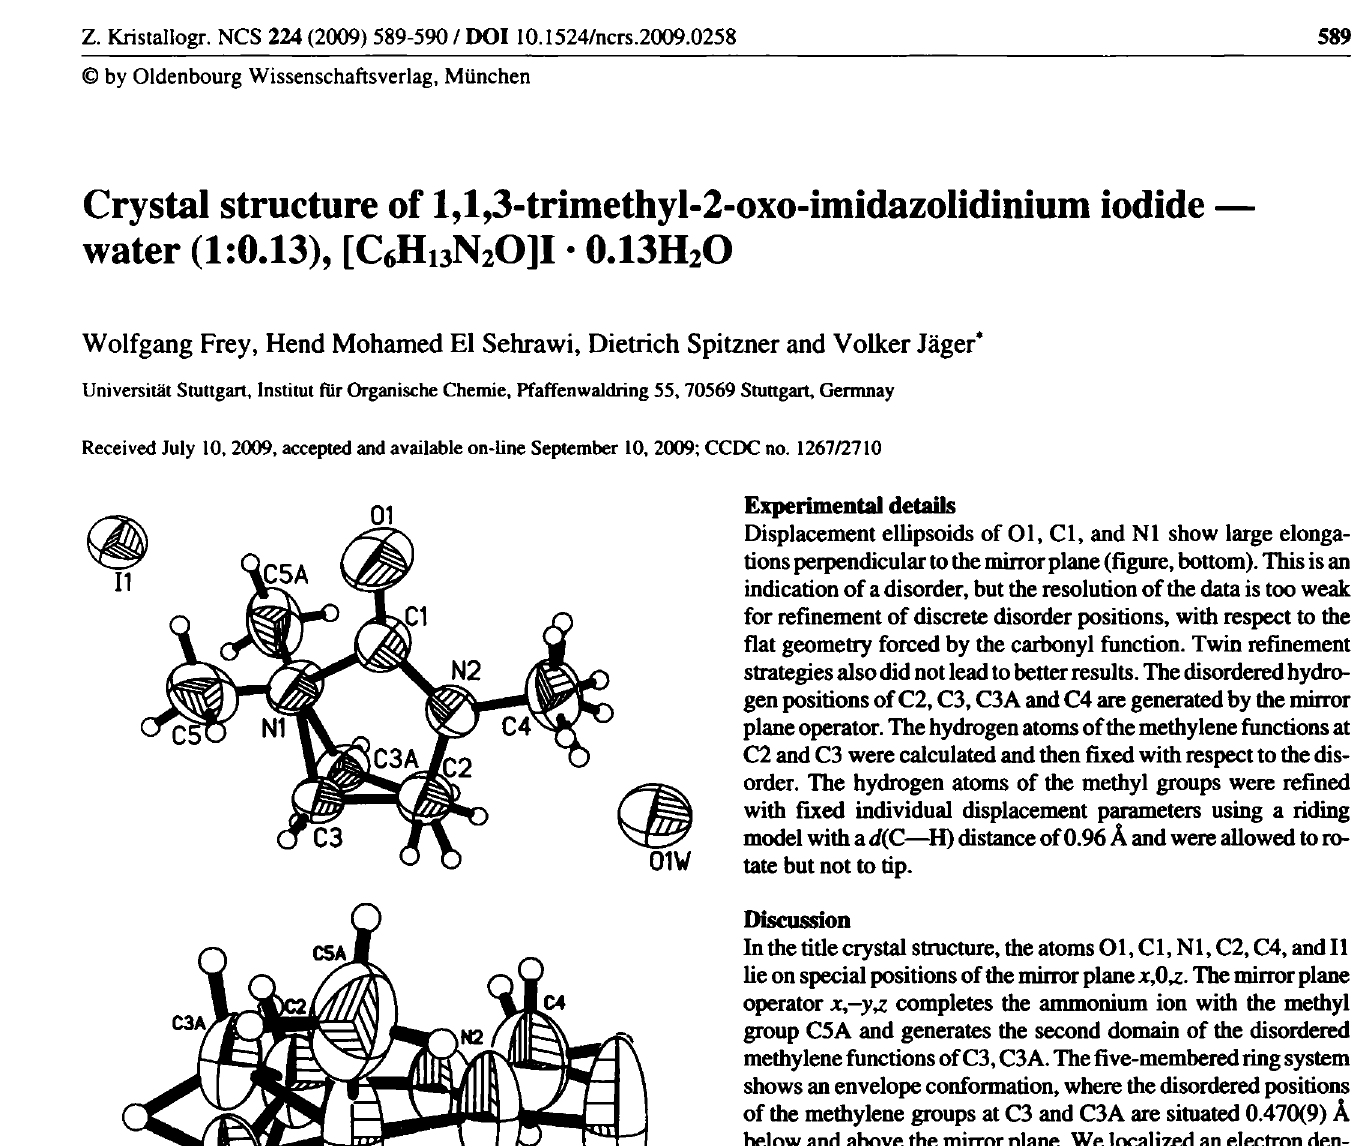
Table 1. Data collection and handling. Crystal: Wavelength: β· Diffractometer, scan mode: